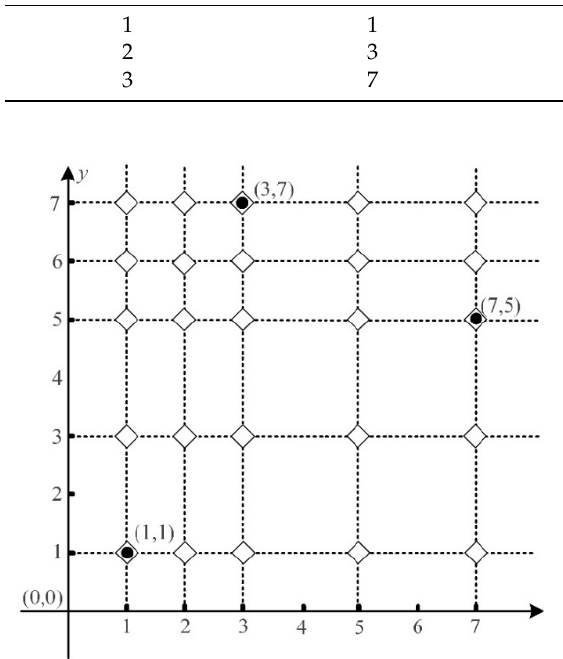
Figure 2. Illustration of the candidate facility